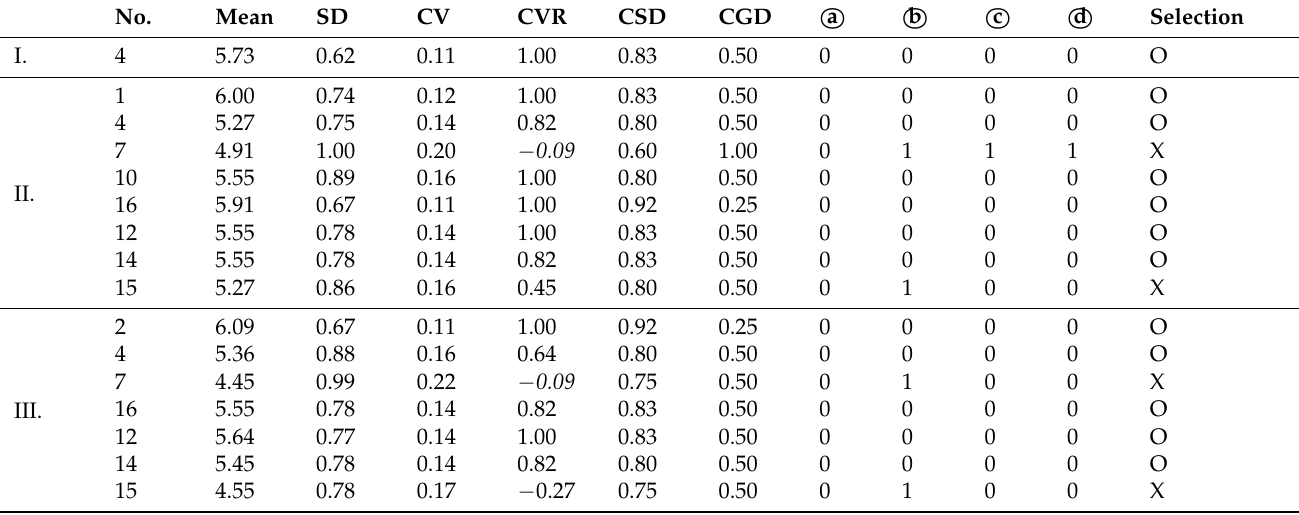
Table 10. Third conformity assessment